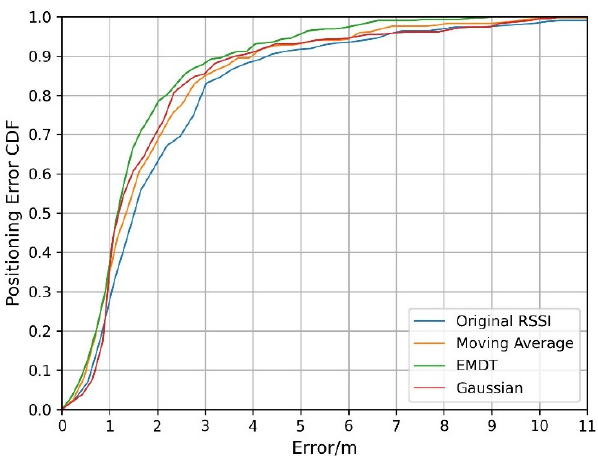
Figure 13. The positioning errors of CDF for different smooth methods.